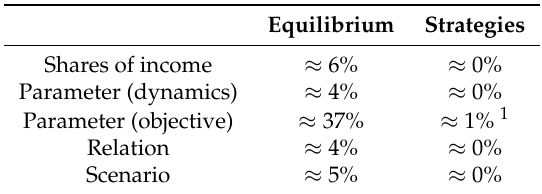
Table 17. Overview of the